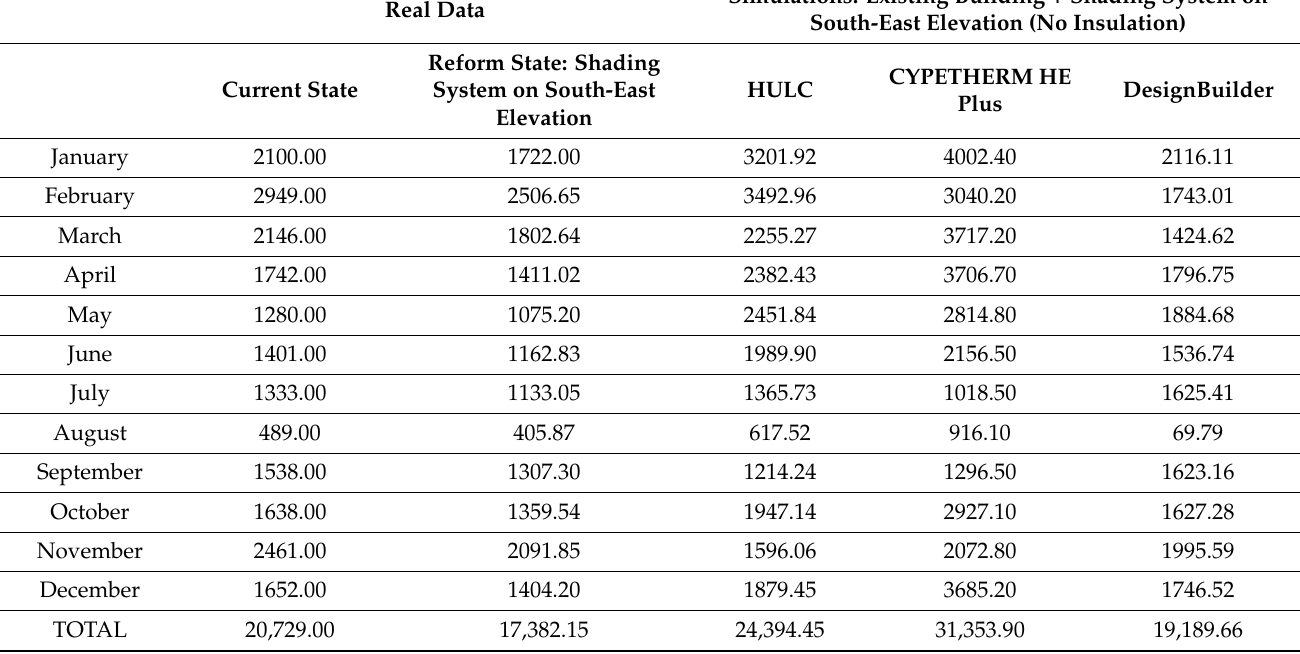
Table 4. Validation of the results: final energy consumption (KWh). Simulations: Existing Building + Shading System Real Data